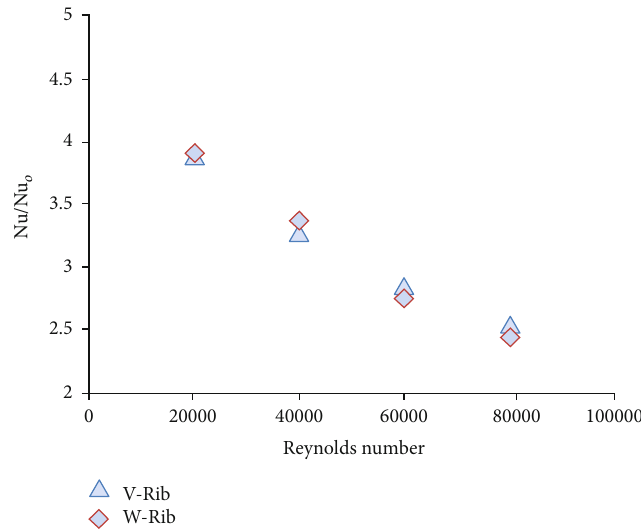
Figure 9: Variation of area averaged Nusselt number ratio with Re .